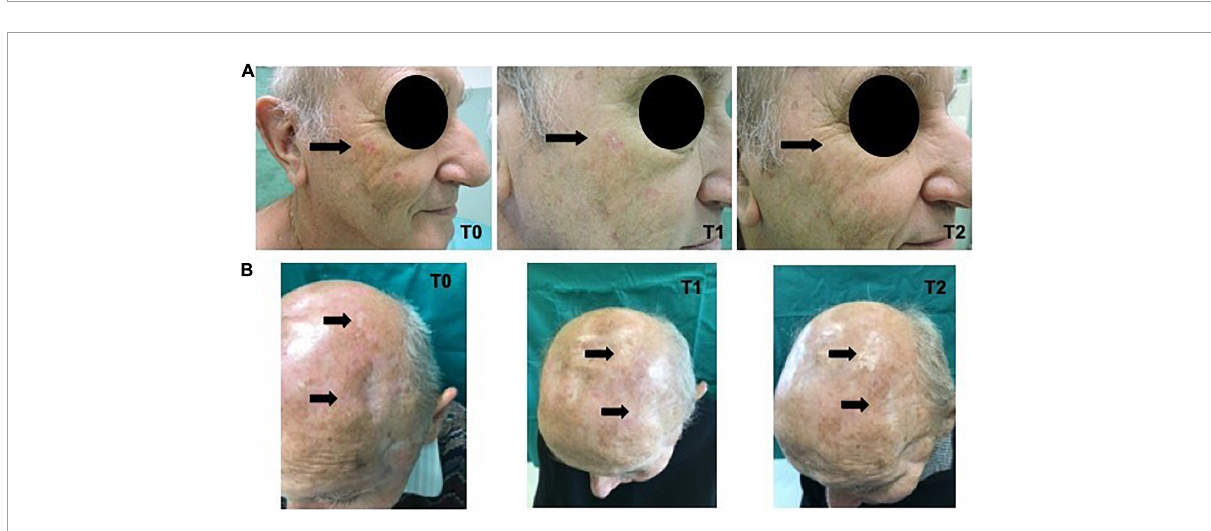
FIGURE4 (A) Immunosuppressed patient. (B) Immunocompetent patient.